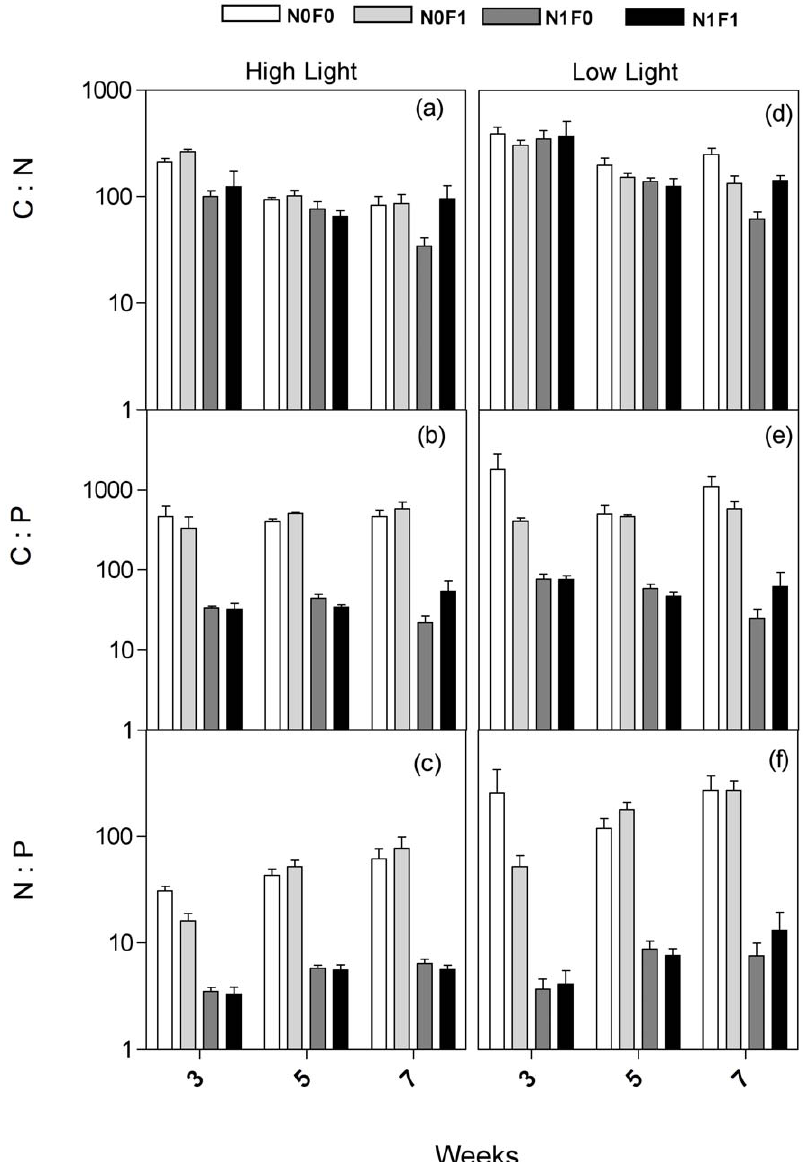
Figure 4. Response of C:N:P stoichiometric ratios in periphyton biomass to different light regimes (high light – a, b, c; low light – d, e, f) and treatments. Treatment abbreviations are the same as in figure 1. Each bar represents mean values for each week ( n =4) + 1SE.